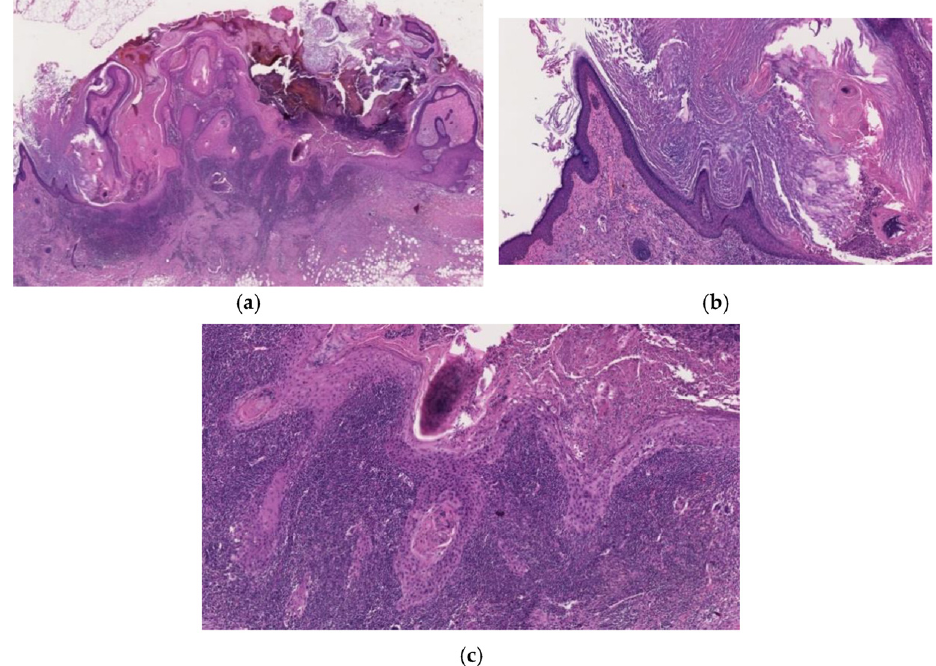
Figure 7. Histopathological findings of mKA. Crateriform architecture is observed, and there is a clear distinction between KA and SCC ( a ). Both sides of the lesion show regressing KA ( b ), whereas the SCC component is in the center ( c ). The boundary between the two components is clear-cut ( a